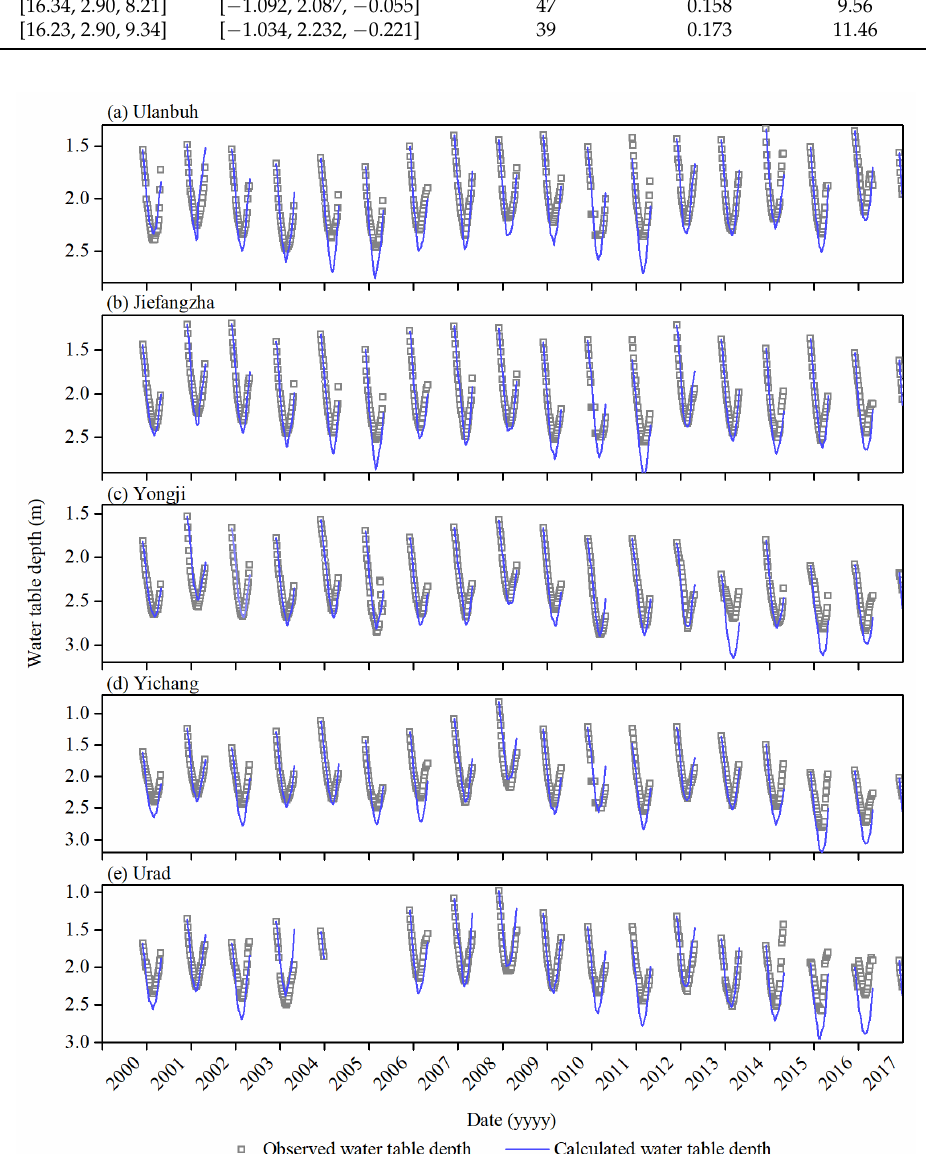
Figure 5. Comparison of calculated and observed water table depth in the freezing-thawing period in ( a ) Ulanbuh sub-irrigation district, ( b ) Jiefangzha sub-irrigation district, ( c ) Yongji sub-irrigation district, ( d ) Yichang sub-irrigation district, and ( e ) Urad sub-irrigation district.